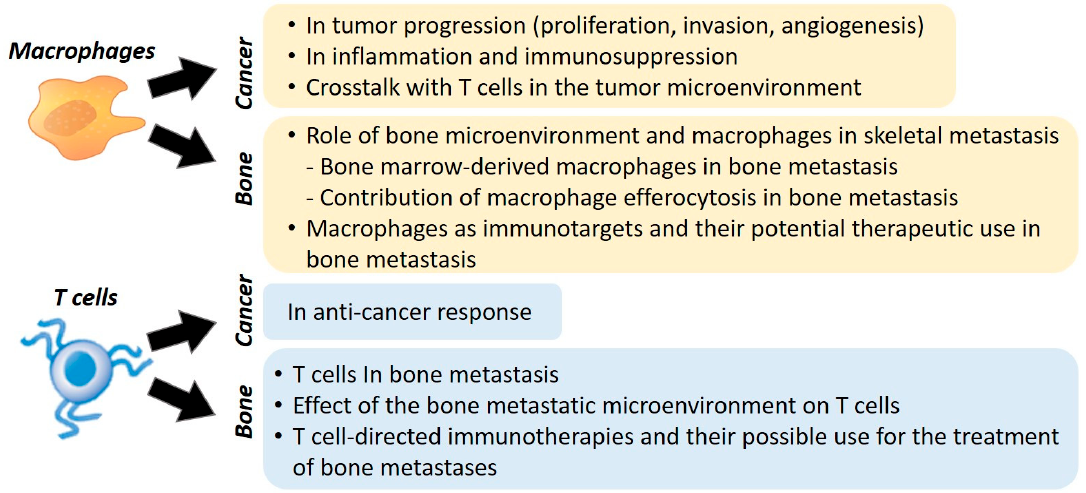
Figure 1. Topics covered in this review.